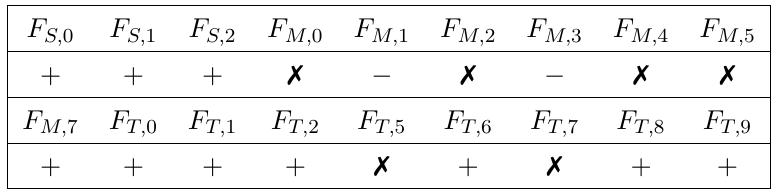
Table 4 . Positivity constraints on individual VBS operator coe(cid:14)cients. + = (cid:0) means the coe(cid:14)cient must be non-negative or non-positive. 7 means that nonzero value is not